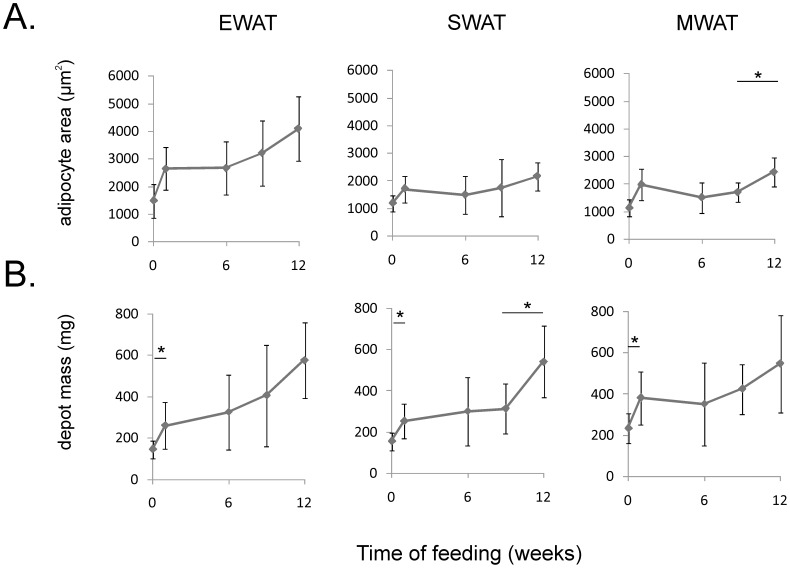
Change of adipocyte cell size and adipose depot mass during high-fat feeding.
A) Adipocyte cell area in epididymal (EWAT), subcutaneous (SWAT) and mesenteric (MWAT) adipose tissue on high-fat diet (HFD). The areas of adipocytes were determined histologically. The values are based upon 200 measurements from each animal. B) Mass of the adipose depots on HFD. 14–15 animals were used for depot weight determination and 6–7 animals for adipocyte size determination. Cell size and depot mass differed over time in all three depots (p<0.05, Kruskall-Wallis analysis, 4 degrees of freedom). *Difference in cell size or depot mass between consecutive time points determined by Mann-Whitney analysis (p<0.05 adjusted to 0.0125 by Bonferroni correction). Error bars indicate standard deviation. Cell size - EWAT: time-point 0–1 weeks U(7) = 6, p = 0.02; 1–6 weeks U(7) = 24, p = 0.94; 6–9 weeks U(7,6) = 16, p = 0.47; 9–12 weeks U(6,7) = 11, p = 0.15; SWAT: time-point 0–1 weeks U(7) = 7, p = 0.02; 1–6 weeks U(7) = 16, p = 0.27; 6–9 weeks U(7,6) = 17, p = 0.56; 9–12 weeks U(6,7) = 9, p = 0.09; MWAT: time-point 0–1 weeks U(7) = 6, p = 0.02; 1–6 weeks U(7,6) = 11, p = 0.15; 6–9 weeks U(6,6) = 10, p = 0.2; 9–12 weeks U(6,7) = 3, p = 0.01; Depot mass - EWAT: time-point 0–1 weeks U(15) = 41, p = 0.003; 1–6 weeks U(15) = 92, p = 0.39; 6–9 weeks U(15,14) = 86.5, p = 0.42; 9–12 weeks U(14,15) = 51, p = 0.02; SWAT: time-point 0–1 weeks U(15) = 26, p = 0.0003; 1–6 weeks U(15) = 108, p = 0.85; 6–9 weeks U(15,14) = 92, p = 0.57; 9–12 weeks U(14,15) = 31, p = 0.001; MWAT: time-point 0–1 weeks U(15) = 29, p = 0.0005; 1–6 weeks U(15,14) = 83, p = 0.33; 6–9 weeks U(14,14) = 60, p = 0.08; 9–12 weeks U(14,15) = 71, p = 0.13.